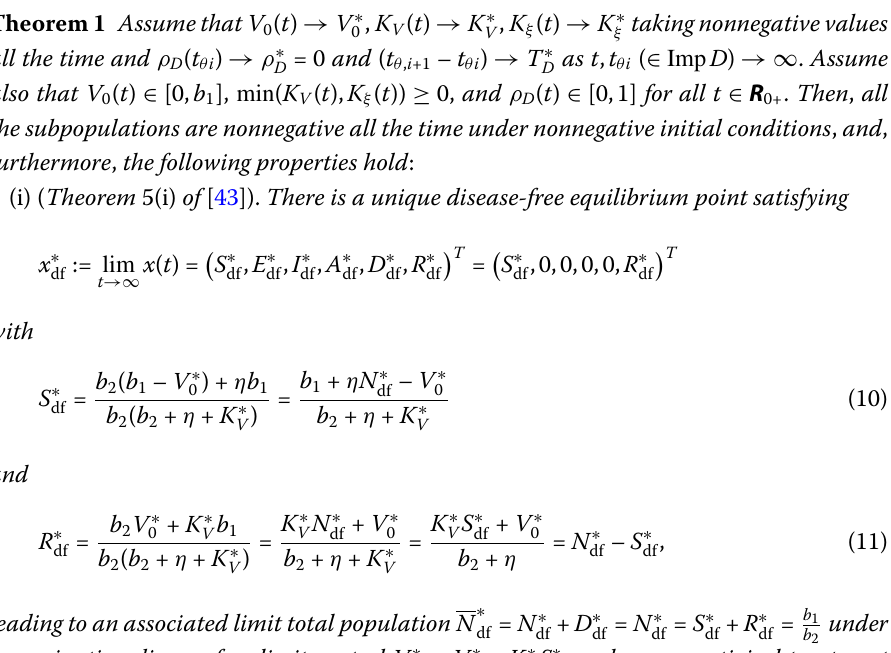
[45, 46]. In particular, a discrete epidemic model is investigated in [14], which possesses a unique nonnegative equilibrium to which the solutions converge, and the case of imperfect vaccination under nonlinear incidence rate is investigated in [16]. On the other hand, in [47], general conditions for maintenance of the positivity of a dynamic system under its discretization are given and discussed. An illustrative flux diagram in the absence of vaccination, antiviral treatment, and corpses removal controls (7)–(9) is shown in Fig. 1. The transitions between various subpopulations of the model (white thick arrows) and their coupled dynamics (black thin arrows), defined by Eqs. (1)–(6), are also